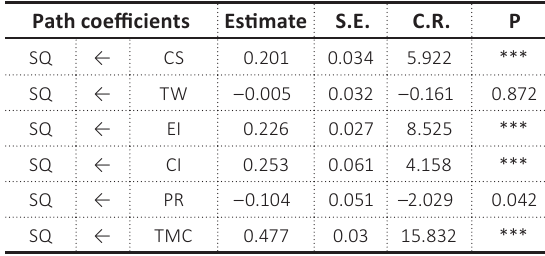
Source: Researchers.